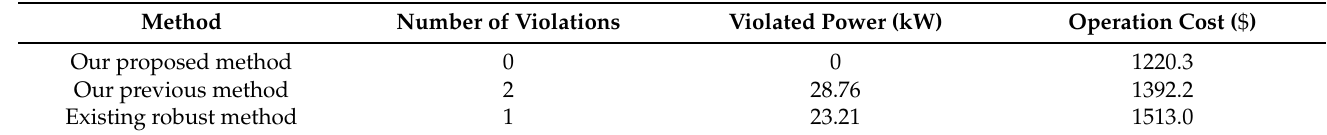
Table 2. Simulation results.